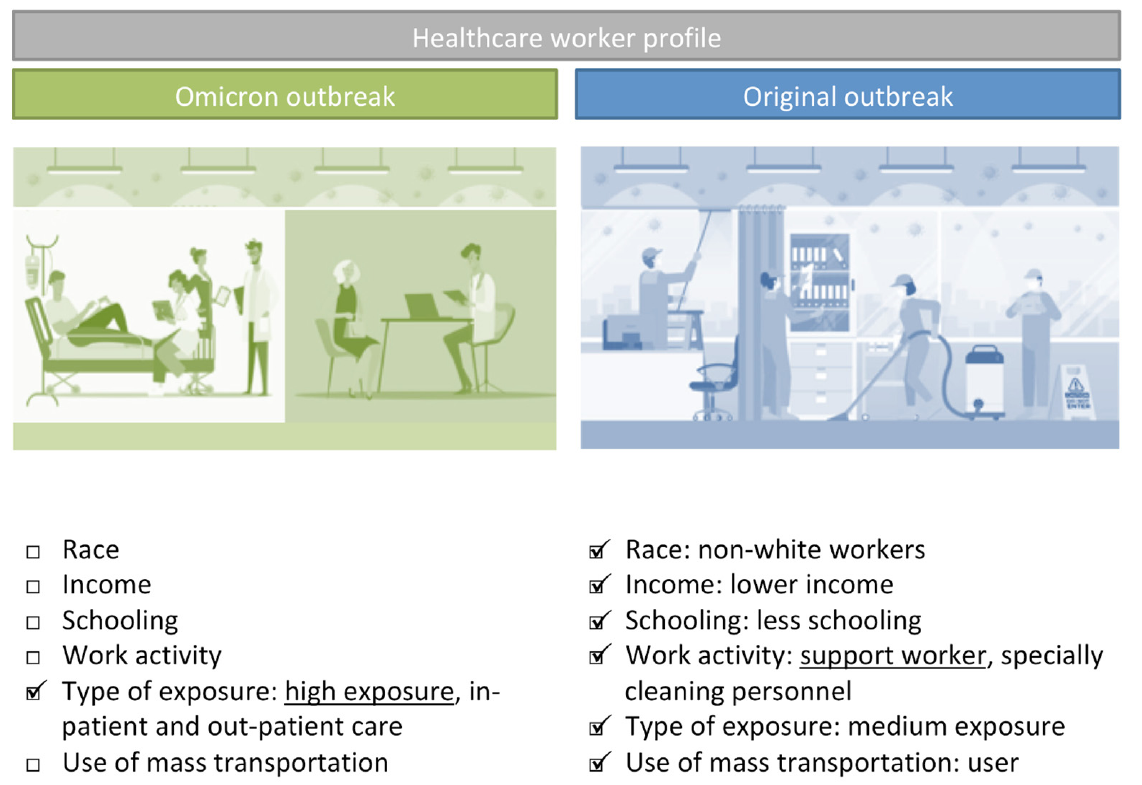
Figure 2. Profile shift from the first SARS‑CoV‑2 outbreak to the Omicron Era. Comparison between the different profiles of SARS‑CoV‑2 positive healthcare workers on the Omicron outbreak (green panel) and the Original outbreak (blue panel). □ 3 represents statistically significant ( p < 0.05) charac‑ teristics associated with SARS‑CoV‑2 positivity.